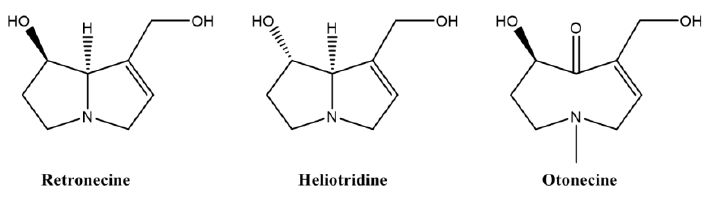
Figure 2. General structure of pyrrolizidine alkaloids.